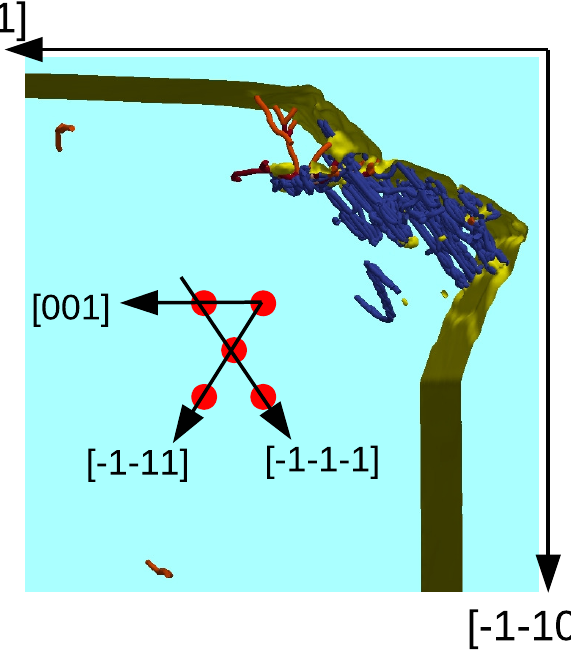
Figure 4. As in Figure 2, but for a rake angle of − 45 ◦ at the end of the cut, L = 100